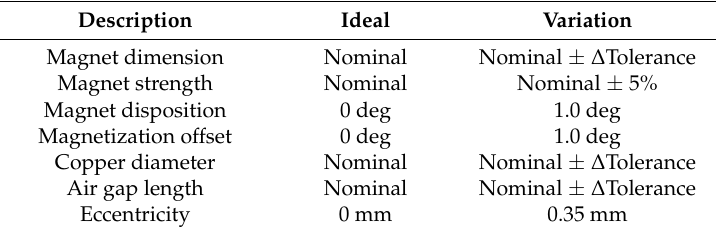
Table 1. Manufacturing variations for some factors of PM motors.